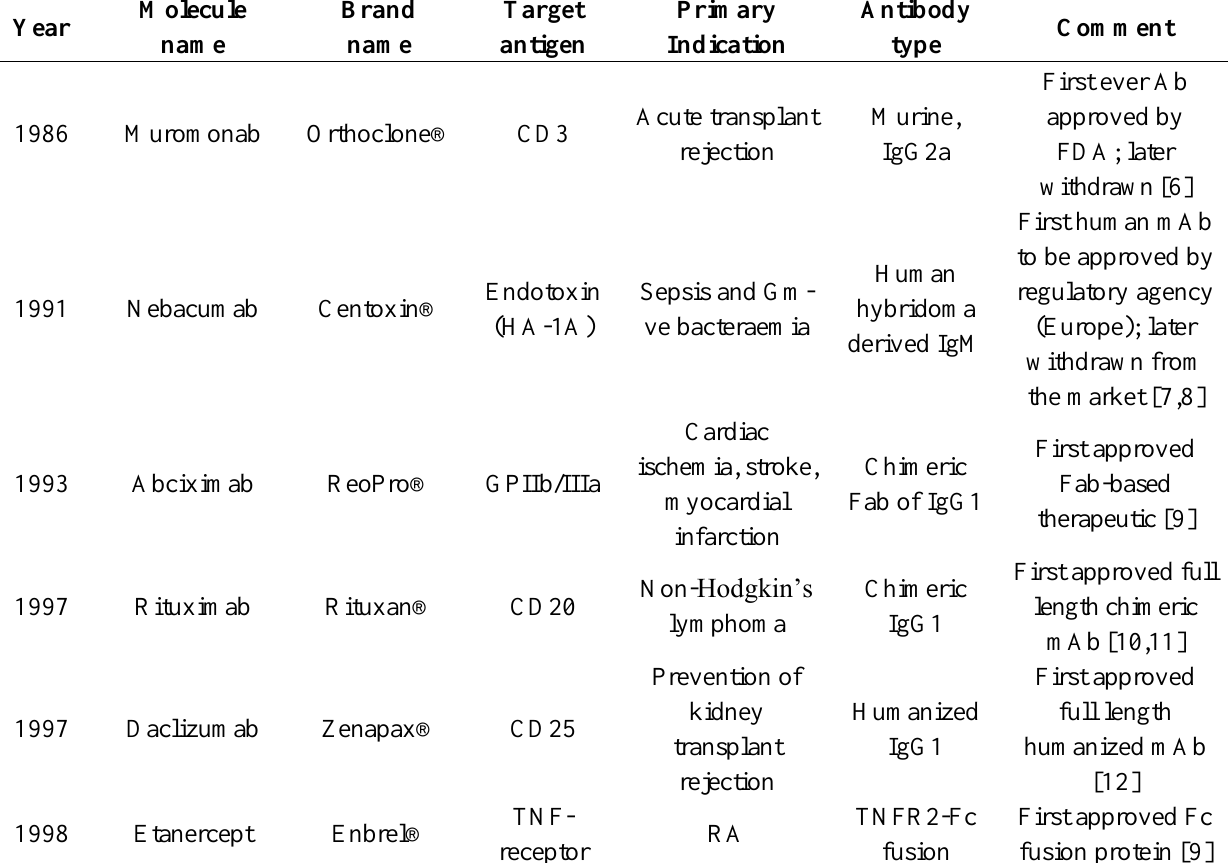
Table 1. Milestones of regulatory approval of monoclonal antibody (mAb)-based